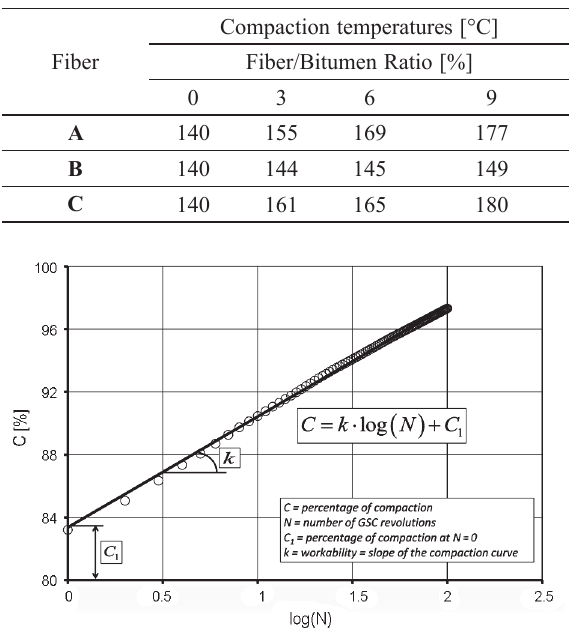
Table 3. Compaction temperatures of the bituminous mixtures